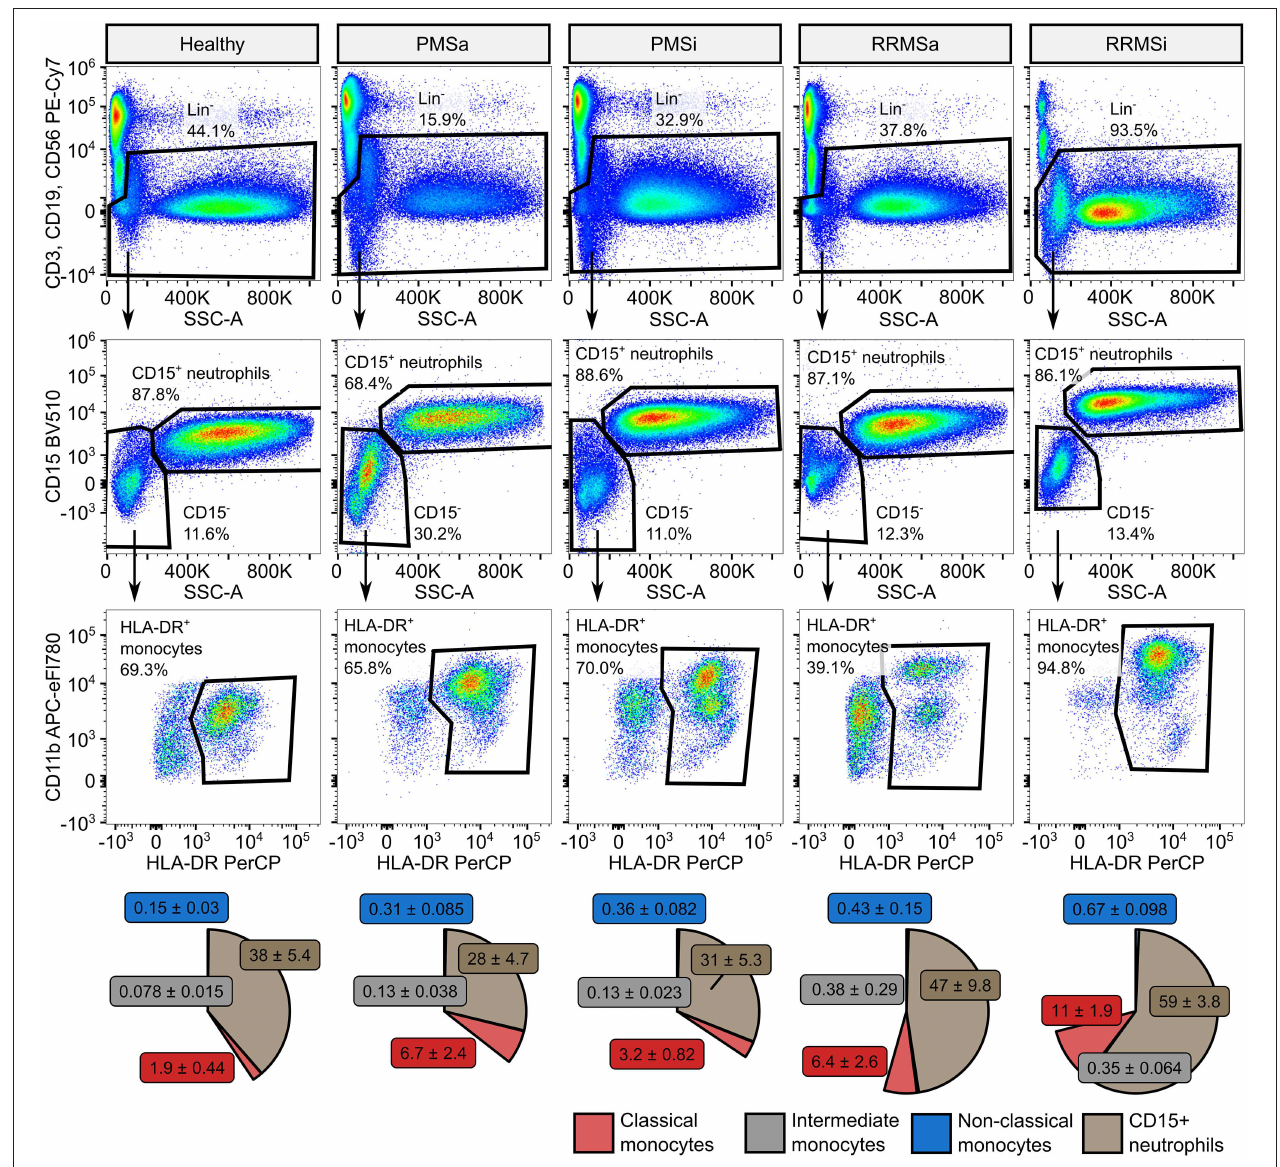
FIGURE 3 | Specific expansion of neutrophil and monocyte compartment in inactive relapsing-remitting multiple sclerosis (RRMSi) individuals. CD15 + neutrophils and monocyte subsets were identified in whole-blood samples from healthy controls ( n = 15) and MS patients stratified by disease course type [active progressive MS (PMSa): n = 14, inactive progressive MS (PMSi): n = 13, active relapsing-remitting MS (RRMSa): n = 8, and RRMSi: n = 30] as presented in Supplementary Figure S1 . Representative flow cytometry results with pre-gating for CD45 + cells are shown. Pie plots display levels of CD15 + neutrophils and classical, intermediate, and nonclassical monocytes as percentage of CD45 + blood leukocytes. Means with SEM are